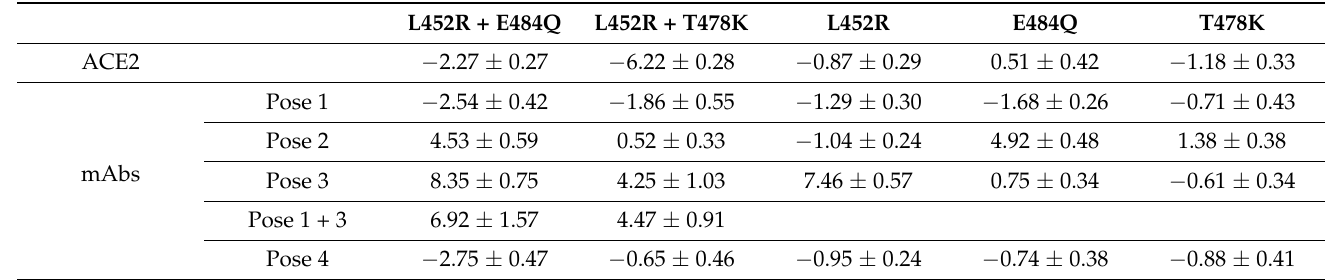
Table 1. Change in BFE for ACE2 and mAbs bound through different